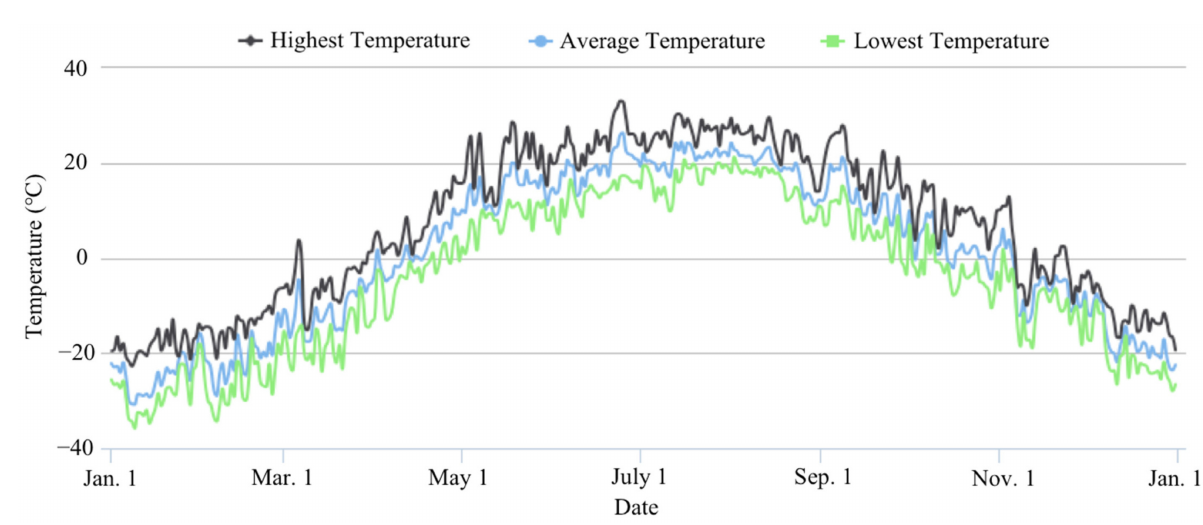
Figure 26. Annual ambient temperature of Heihe, China in 2013